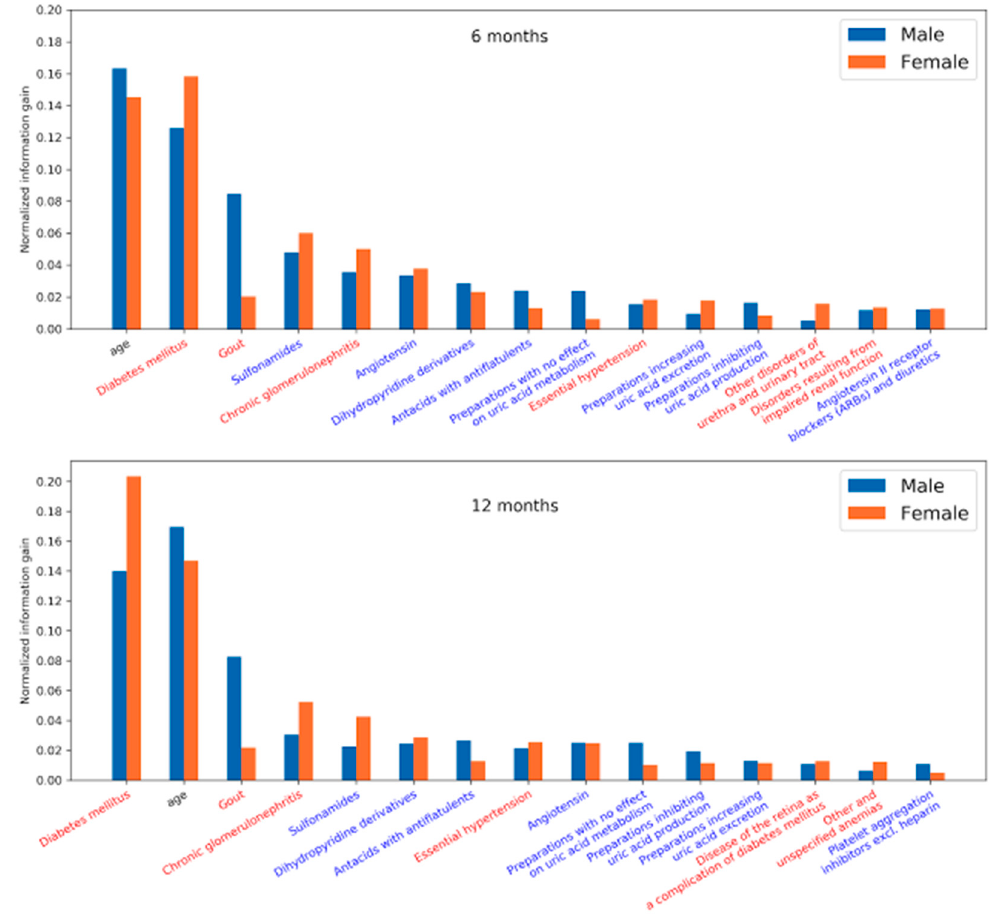
Figure 8. Feature importance for the LightGBM models for men and women for 6 and 12 months. The color of the x-axis labels is related to the type of feature: comorbidities are red, medications are blue, and age is black.